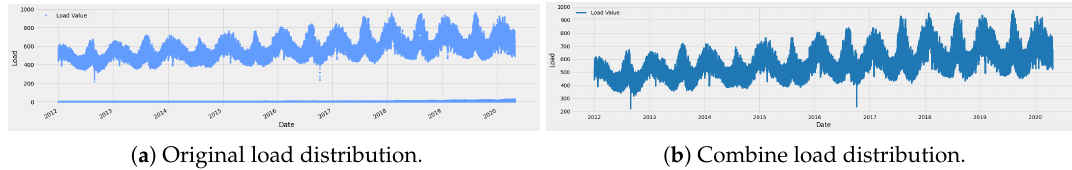
Figure 9. Actual and combined energy power